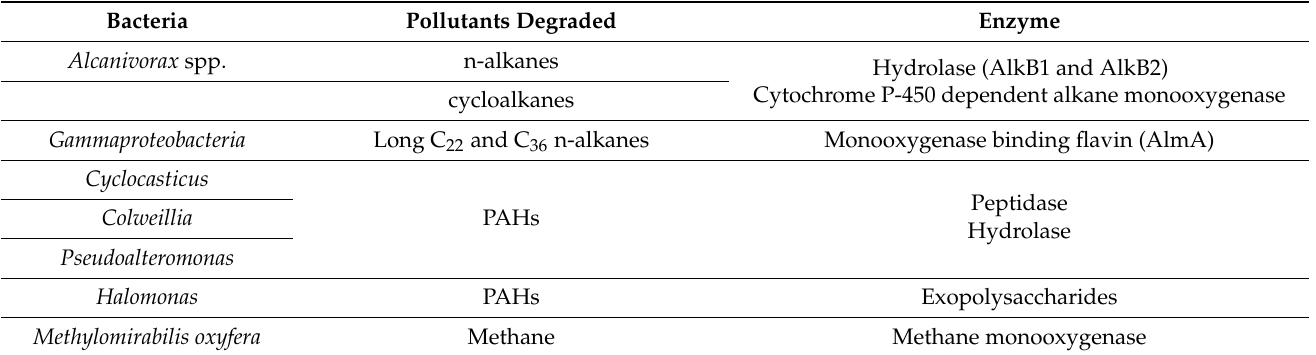
Table 1. Principal enzyme involved in bacteria crude oil